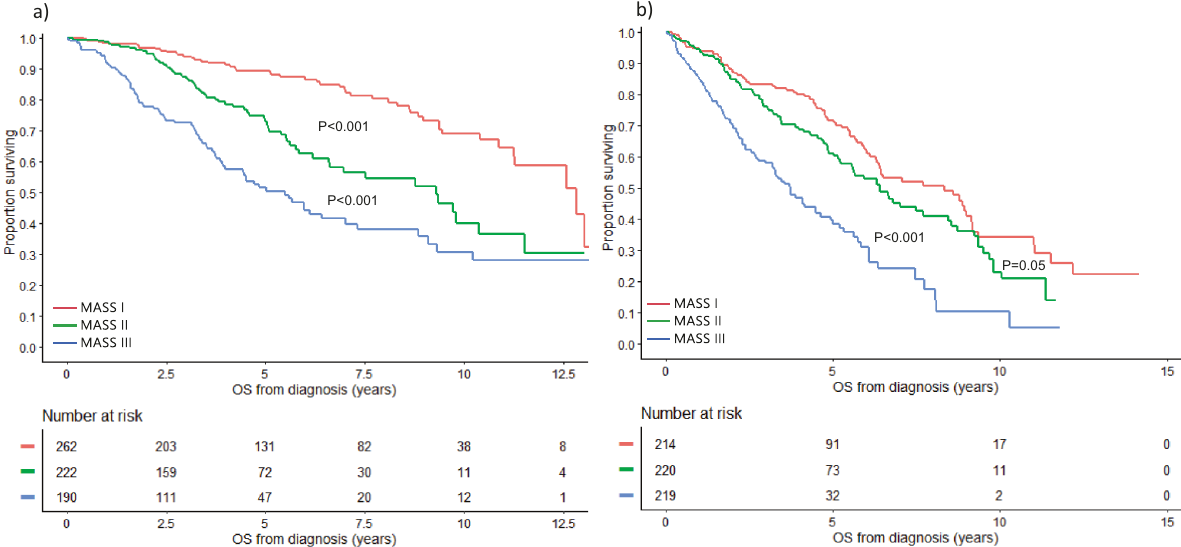
Fig. 3 OS based on the MASS by age. OS (years) in MM patients with MASS I (red curve), MASS II (green curve), and MASS III (blue curve) who are a <65 and b ≥ 65 years of age. MASS Mayo Additive Staging System, MM multiple myeloma, OS overall survival. The P values for each pair of groups are presented between the corresponding curves.